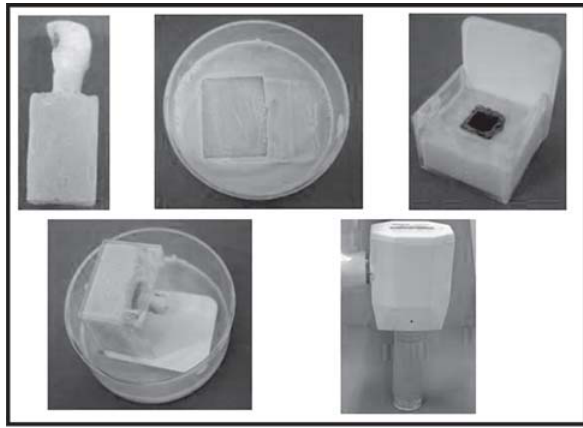
FIGURE 1- Device for achievement of